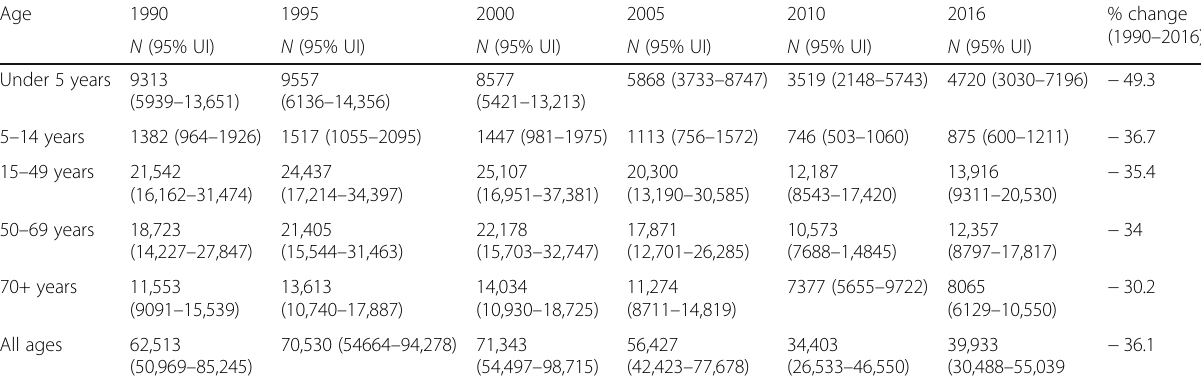
Table 3 Number of deaths from tuberculosis (with 95% uncertainty interval, UI) by age in Nigeria, 1990 – 2016